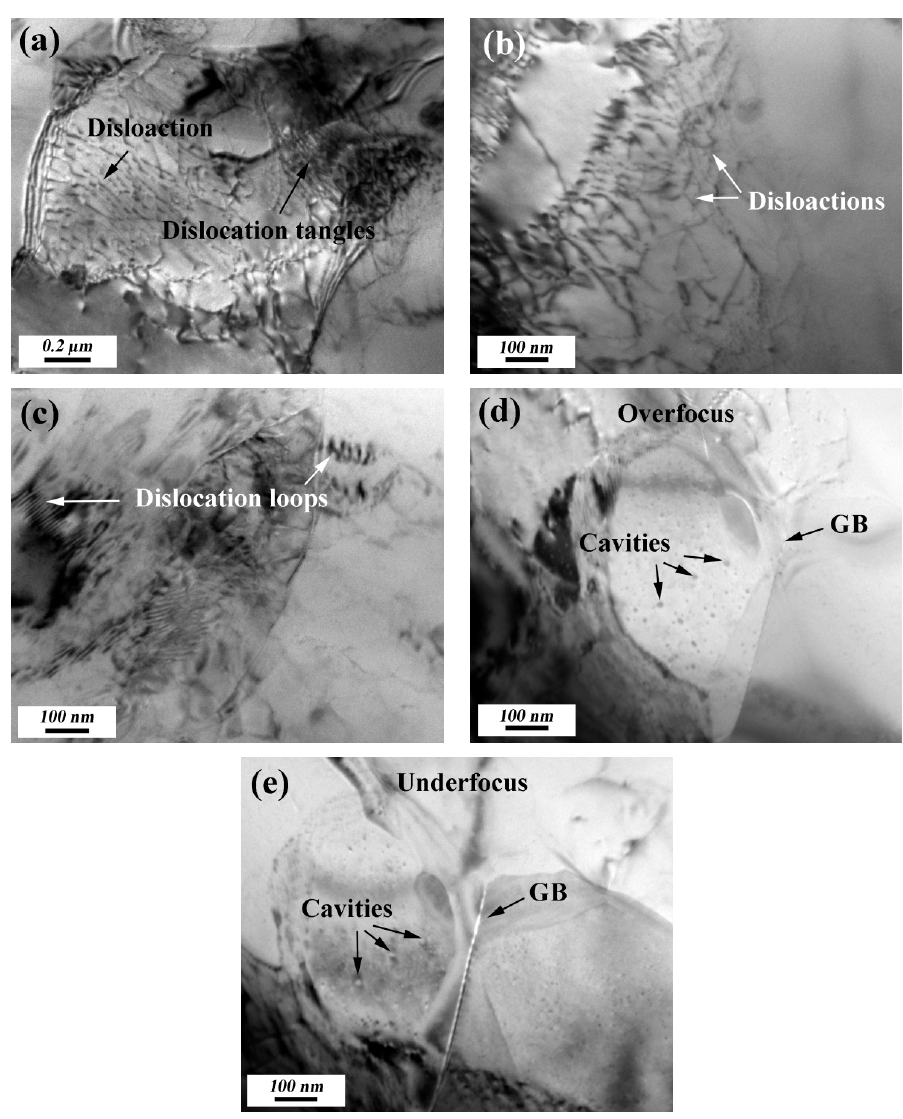
Figure 2. Bright field TEM images of samples with 10 16 ions·cm − 2 irradiation: ( a , b ) dislocation and dislocation tangle; ( c ) dislocation loop; and ( d , e ) cavity.